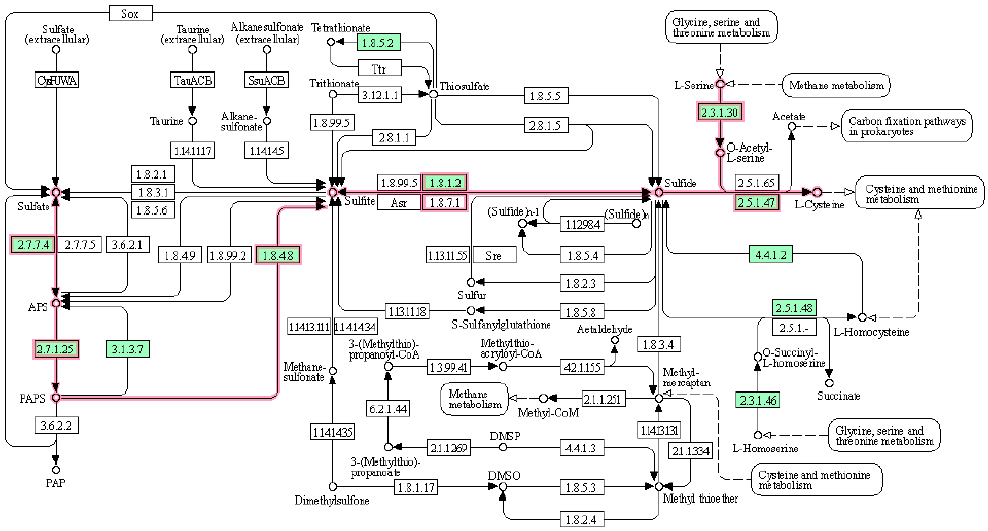
Figure 3. Sulfur pathway from S. epidermidis RP62A metabolism (KEGG database). The pathway for cysteine synthesis is highlighted in